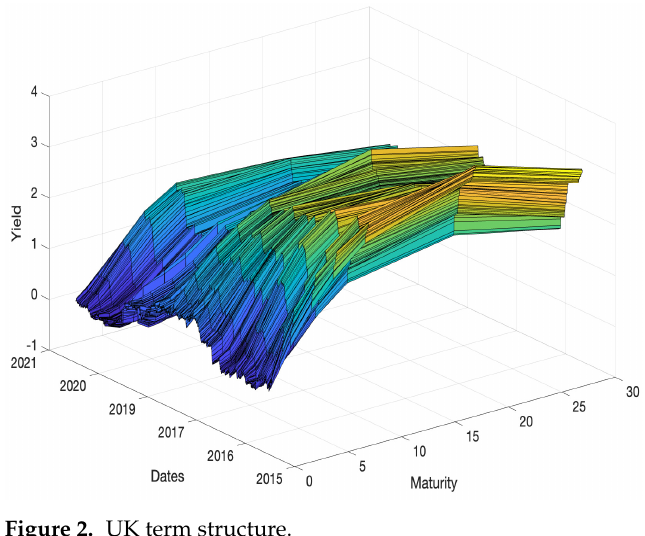
Figure 2. UK term structure.